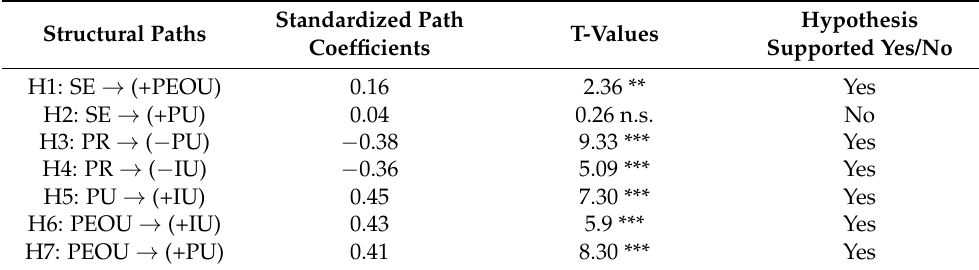
Table 8. Standardized regression weights for the model. Standardized Structural Paths